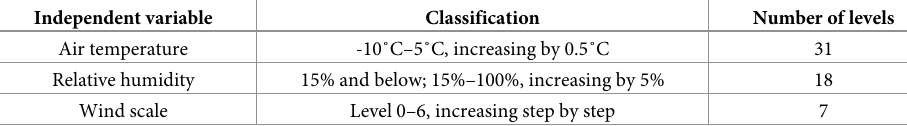
Table 3. Classification criteria for valid sample